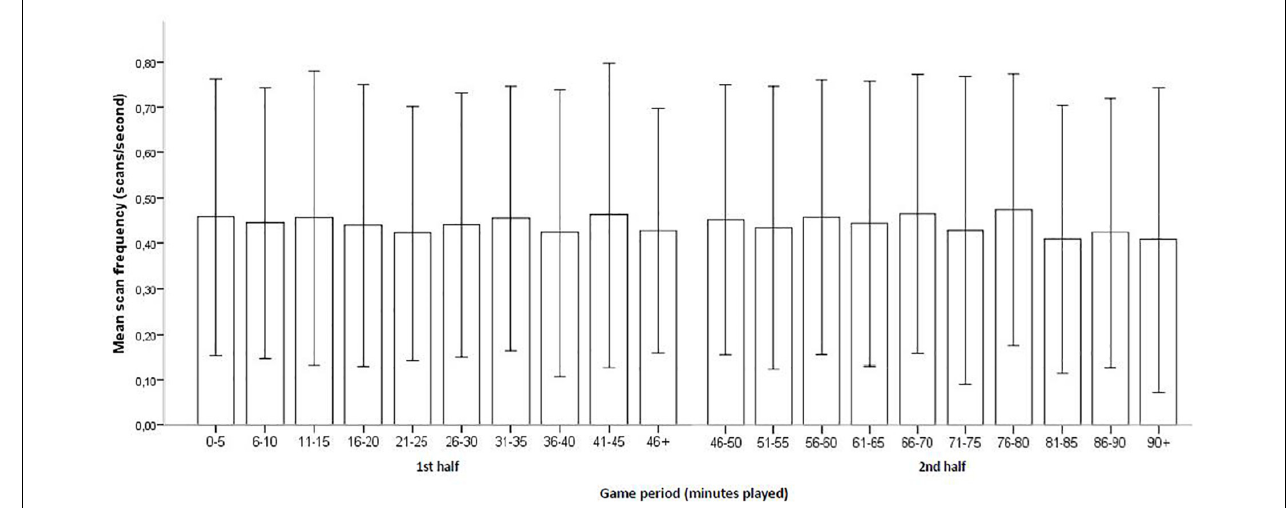
FIGURE 5 | Accumulated game time and mean scan frequency (with SD error